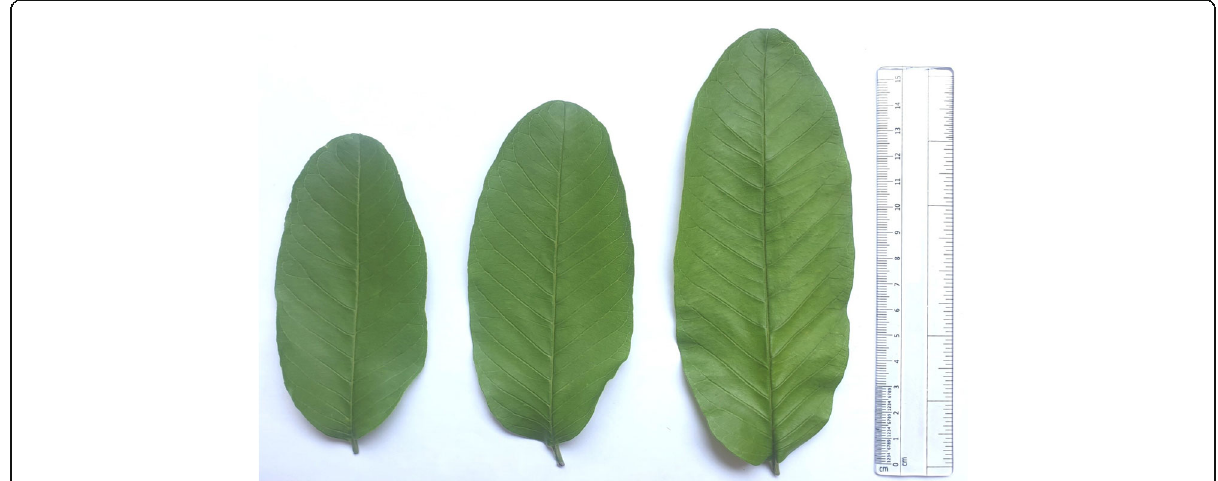
Fig. 2 Psidium guajava